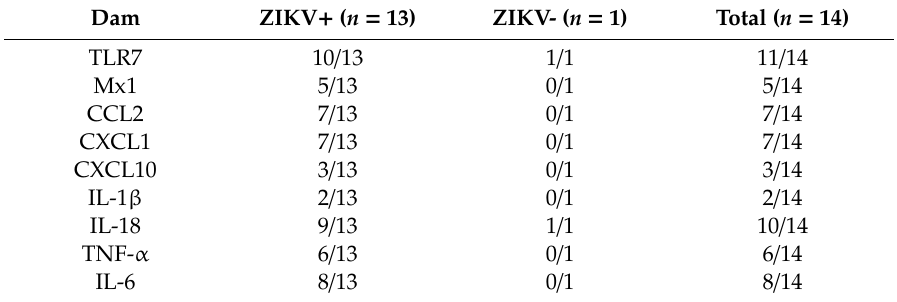
Table 4. Increased expression of inflammatory factors by the placenta associated with embryos from ZIKV-infected